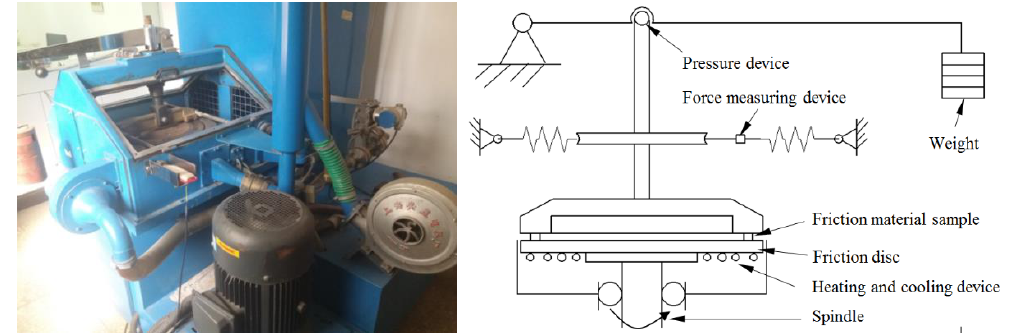
Figure 1. JF151E-type friction test apparatus of the brake shoe and its principle diagram.